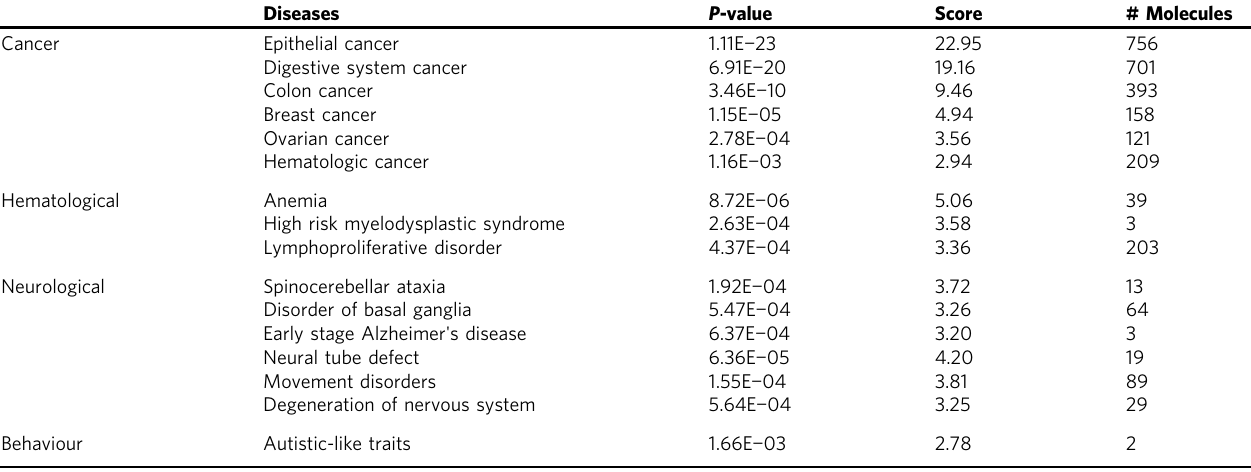
Table 2 The most enriched functional annotation disease clusters of APE1 – RNA targets identi fi ed by Ingenuity Pathway